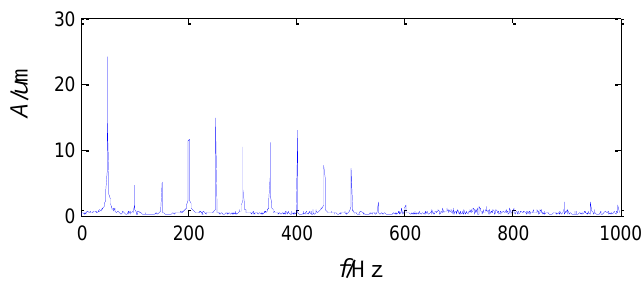
Figure 6. The FFT spectrum of the sensor-dependent vibration signal in frequency domain.